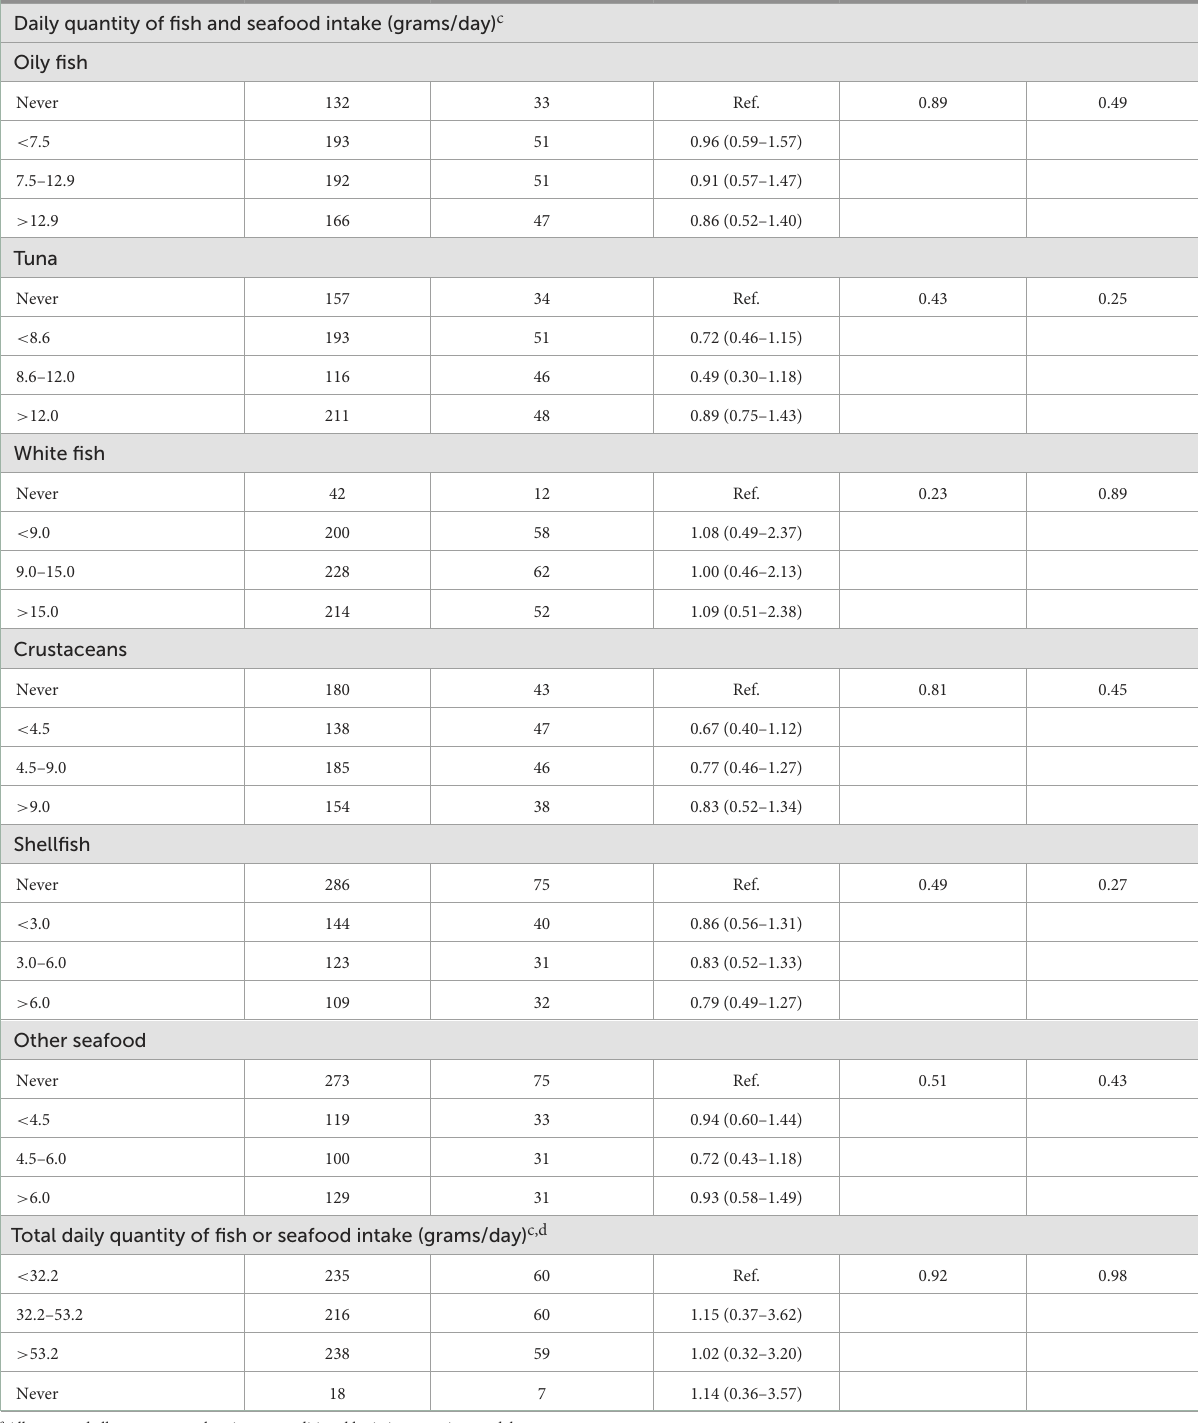
a Allcasesandallspousecontrolsusingunconditionallogisticregressionmodels. b Multivariablemodel:adjustedforage,sex,ethnicity,stateandsmokingstatus. c Numberofparticipantswithmissingdata:dailyquantityoffishorseafoodintake(83),totaldailyquantityofanyfishorseafoodintake(3). d